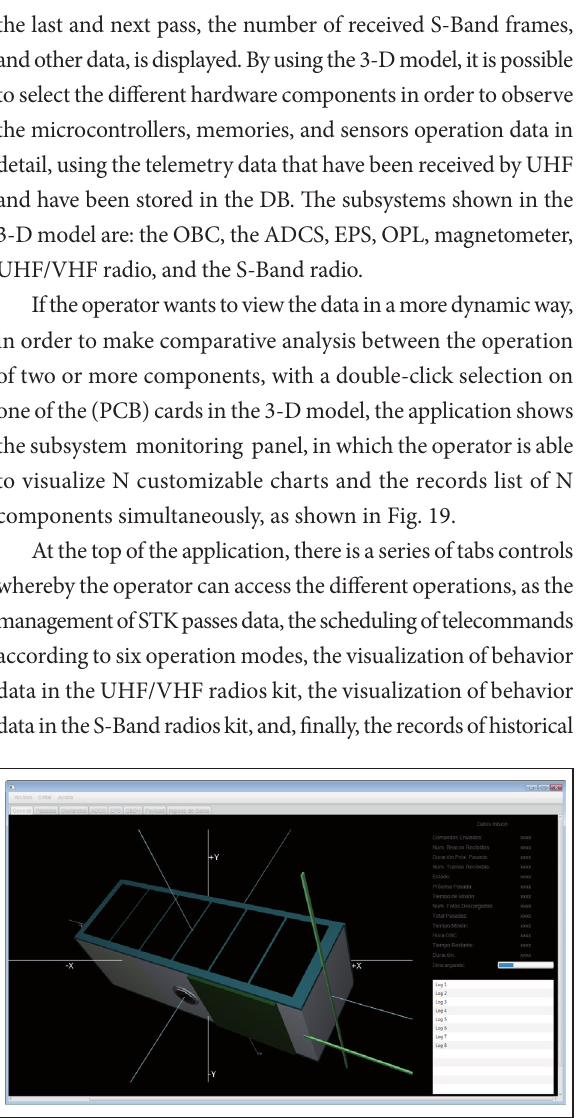
figure 18. Libertad-2 3-D view on the GSCM&C main window.